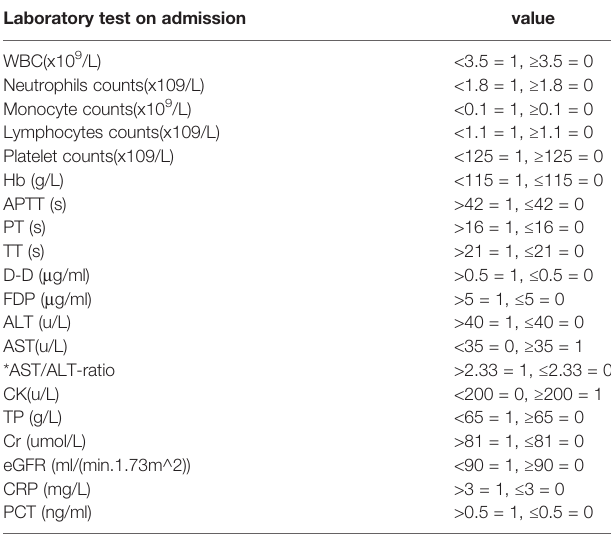
TABLE 6 | The independent variables and their assignment incorporated into cox regression